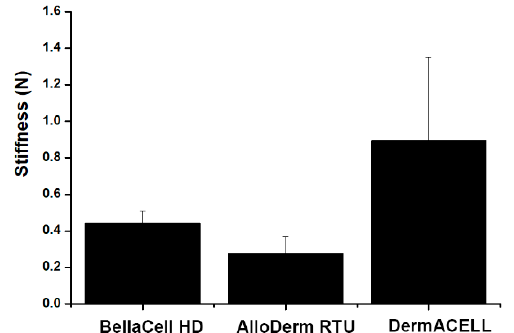
Figure 5. Stiffness testing. Stiffness testing was performed using a custom test fixture. The custom test fixture was fabricated on the basis of American Society for Testing and Materials (ASTM) specification #F1306. It displays a stiffness of 0.90 N/mm for DermACELL, 0.28 N/mm of AlloDerm RTU, and 0.44 N/mm for BellaCell. Each datum represents the ±SEM of three independent experiments.